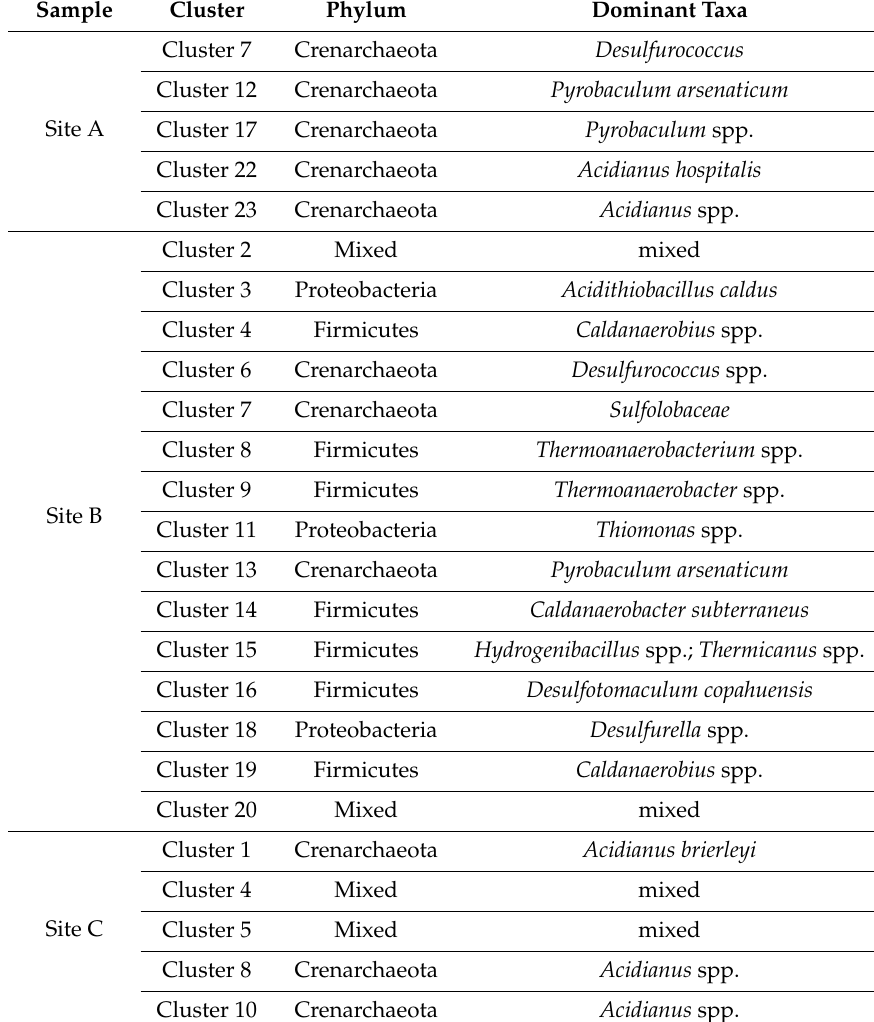
Table 3. Taxonomic assignment of Sites A, B, and C CheckM validated